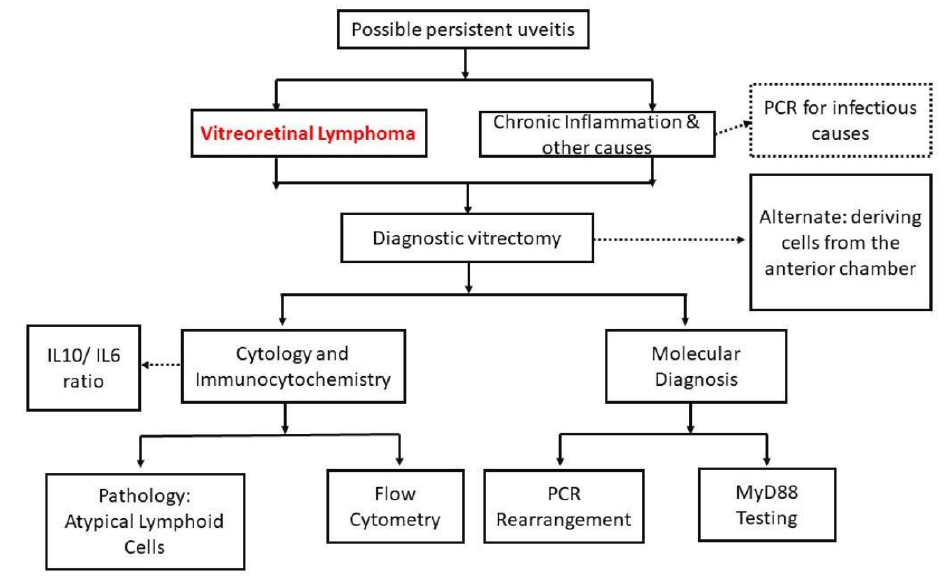
Figure 1. Flowchart representing the different diagnostic options that exist to home in on a potential VRL